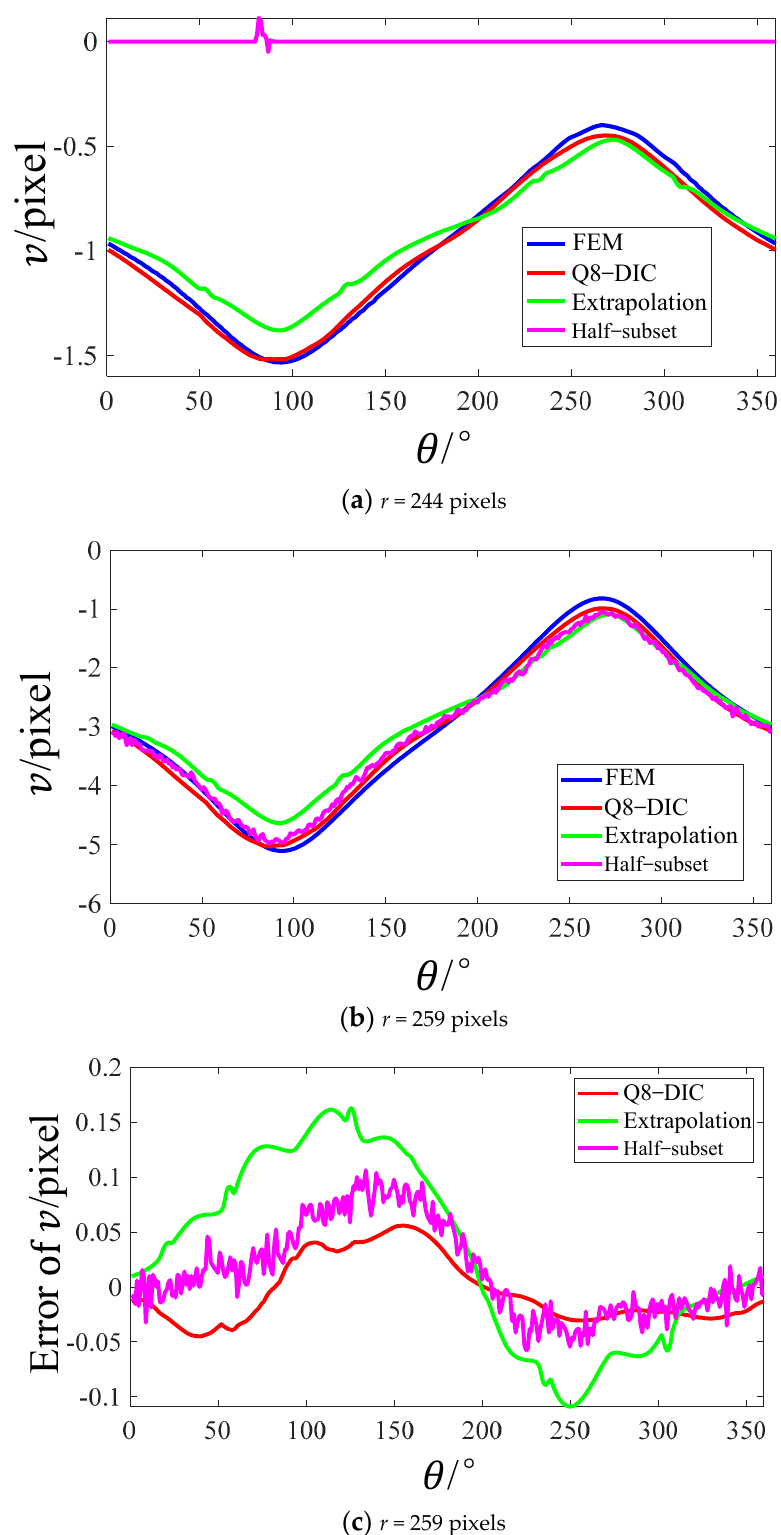
Figure 15. Displacements and measurement errors near ring edge: ( a ) r = 244 pixels, ( b ) r = 259 pixels, and ( c ) measurement errors of displacements ( r = 259